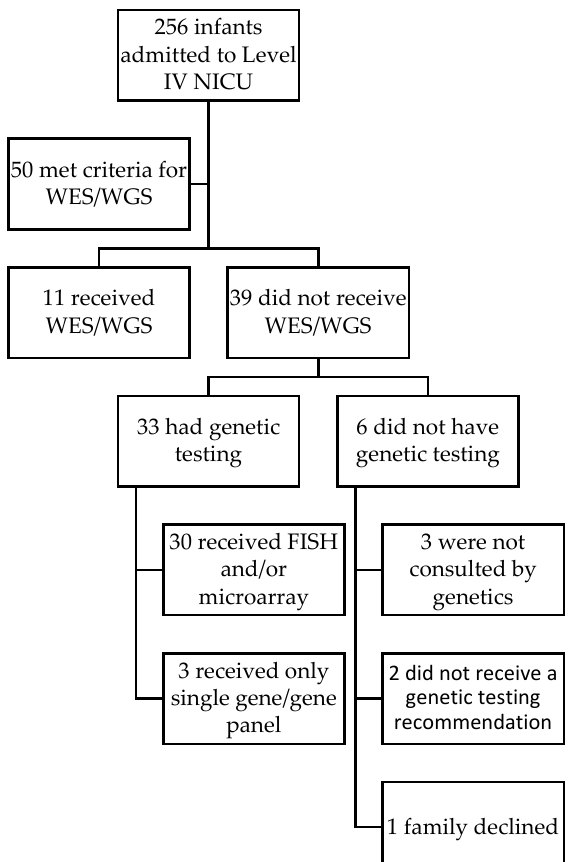
Figure 1. Uptake of WES/WGS. 50 neonates met criteria for WES/WGS. However, only 22% (11/50) received it within the study timeframe. Of the 39 who did not receive WES/WGS, only 1 family declined genetic testing. Of the remaining 39, six received no genetic testing and 33 received other genetic testing that did not include WES/WGS.